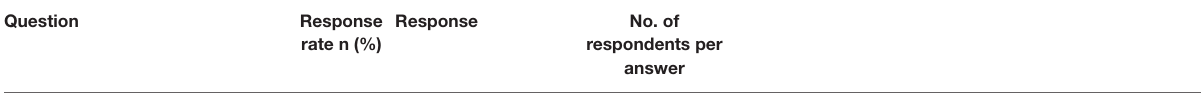
Response No. of rate n (%) respondents